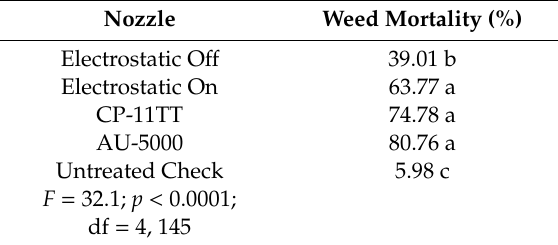
Table 6. Mean [a] weed mortality (%) estimated by visual sampling during year